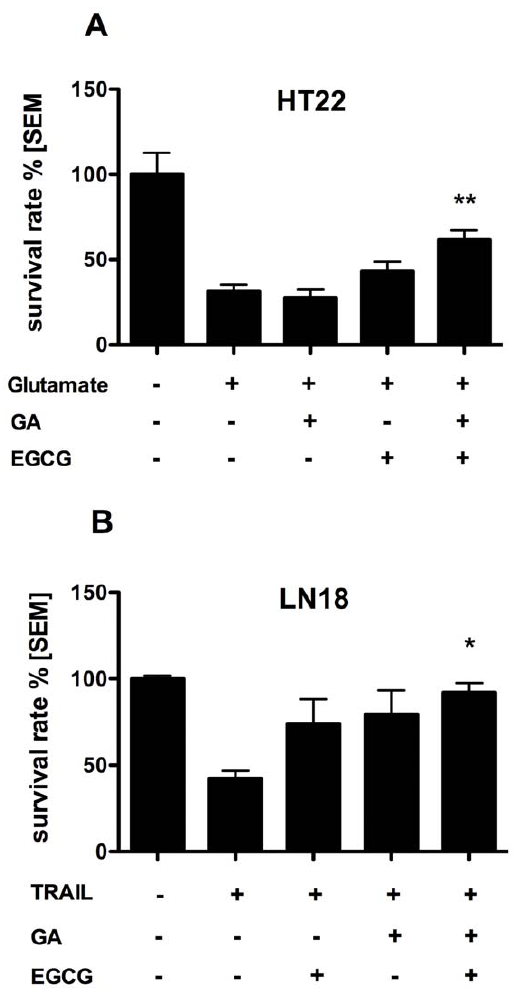
Figure 1. EGCG and GA in combination inhibit death of CNS cells invitro . Survival of murine HT22 neuronal cells (A) and human glioblastomal LN18 cells (B) was determined in a crystal violet assay after induction of apoptosis by incubation with Glutamate (5 mM) (A) or TRAIL (20 ng/ml) (B). EGCG (10 m g/ml) and/or GA (12.5 m g/ml) were added to the culture 2 h before apoptosis induction, *p , 0.05, **p , 0.001, representative of 2 experiments.